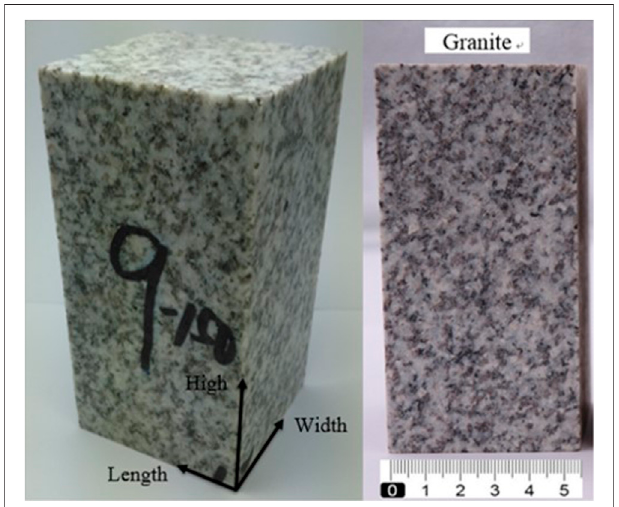
FIGURE 1 | Granite tested in the true triaxial compression experiment.